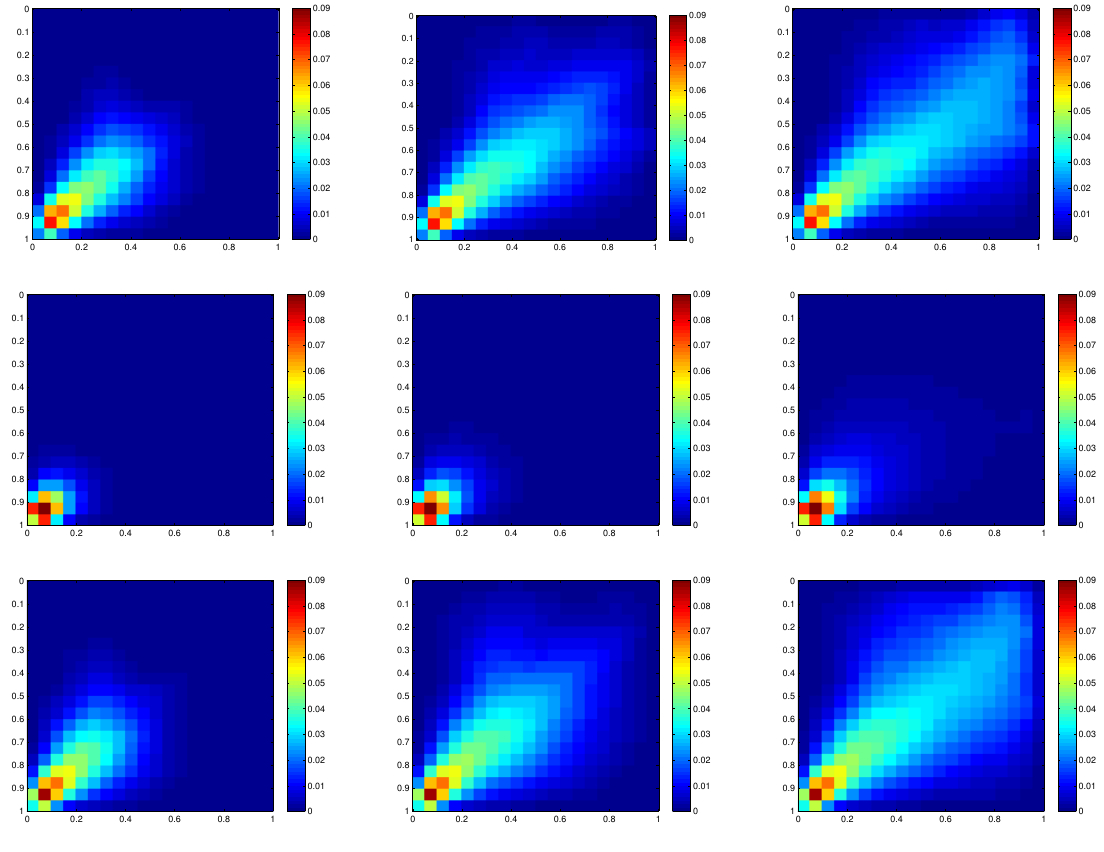
Figure 5. First row: Fine-scale solutions c . Second row: GMsFEM solutions c h (one multiscale basis function per edge for both velocity and flux-concentration). Third row: GMsFEM solutions c (two multiscale basis function per edge for both velocity and H flux-concentration). From left column to right column: T = 0 . 01 , 0 . 02 , 0 . 1 . We use κ = κ f = f , H = c 2